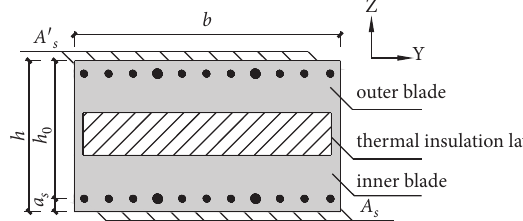
Figure 14: Schematic diagram of a normal section of the bidi- rectional